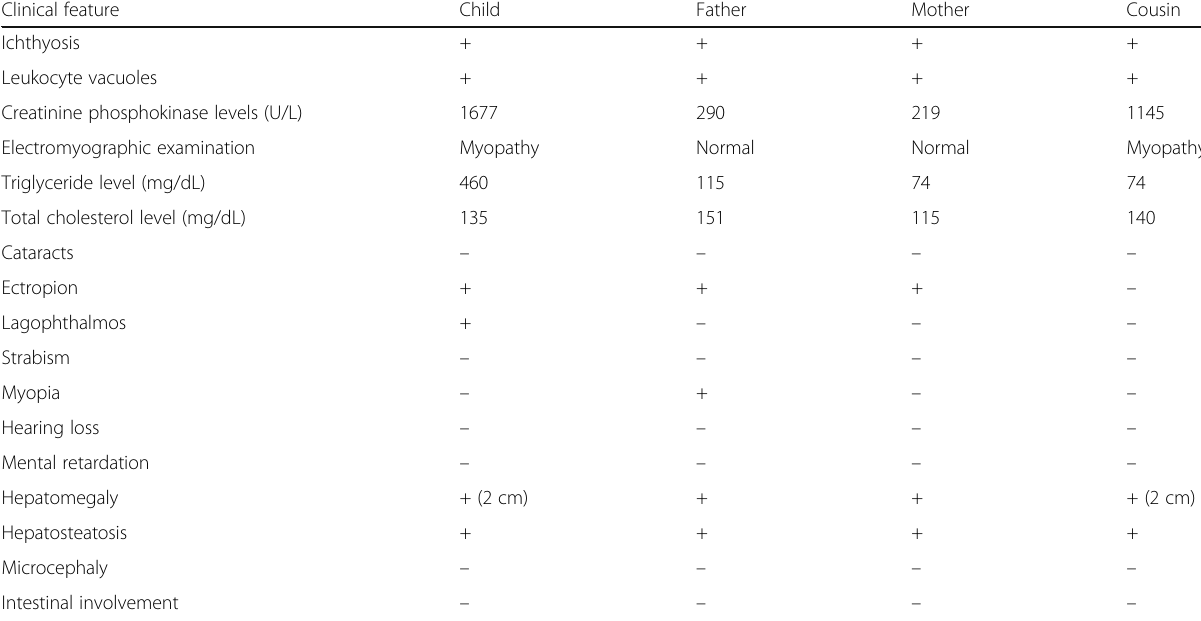
Table 1 Clinical and laboratory features of patients with Chanarin-Dorfman syndrome Clinical